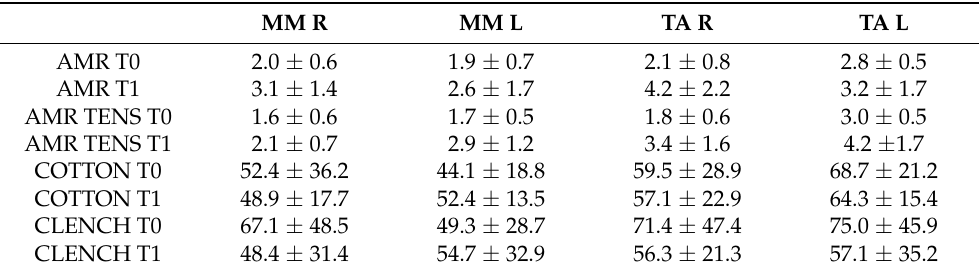
Table 3. Mean values ( µ V) and standard deviations. Legend: MM = masseter muscle; TA = temporal muscle; L = left; R = right; T0 = pre-treatment period; T1 = post-treatment period; AMR = muscular activity at rest; AMR TENS = muscular activity at rest after transcutaneous electrical neural stimula- tion; COTTON = force exerted on the maximum voluntary clenching on cotton rolls; CLENCH = force exerted on the maximum voluntary clenching on